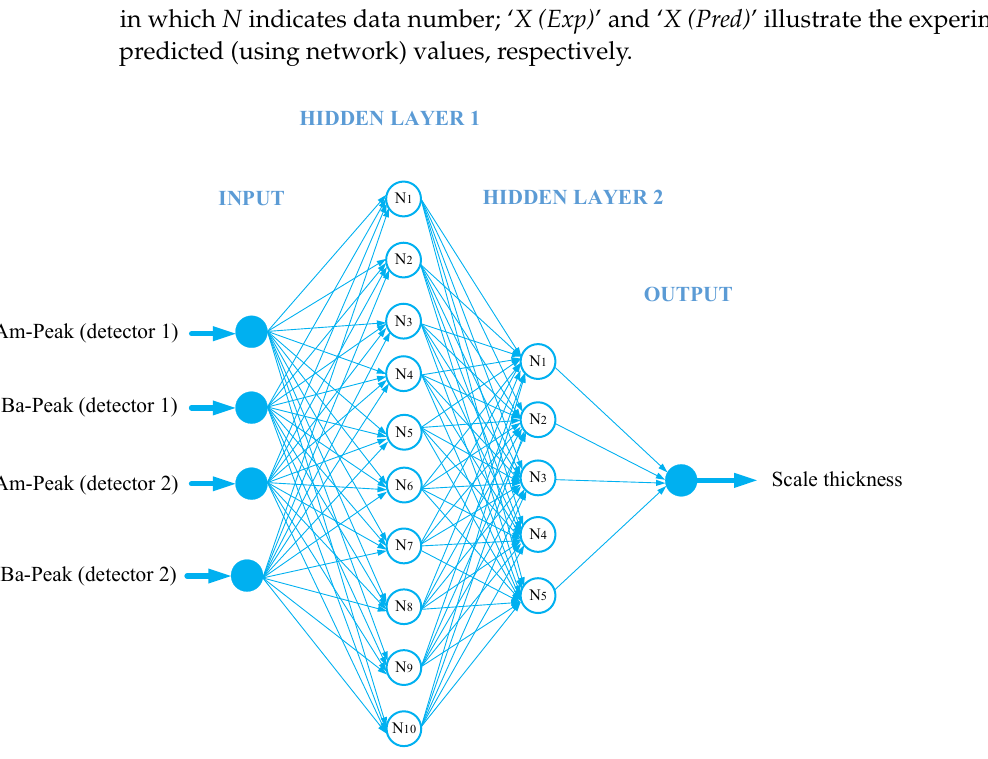
Figure 5. Structure of designed MLP neural network.